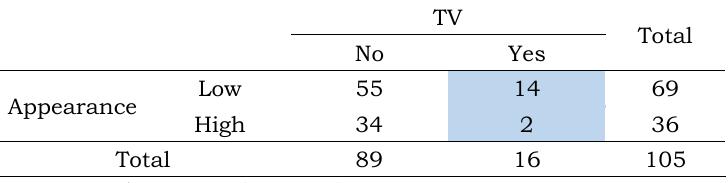
Table 3. Cross tabulation between appearance and TV from 2008 to 2010 TV Total No Yes Low 28 69 97 Appearance High 25